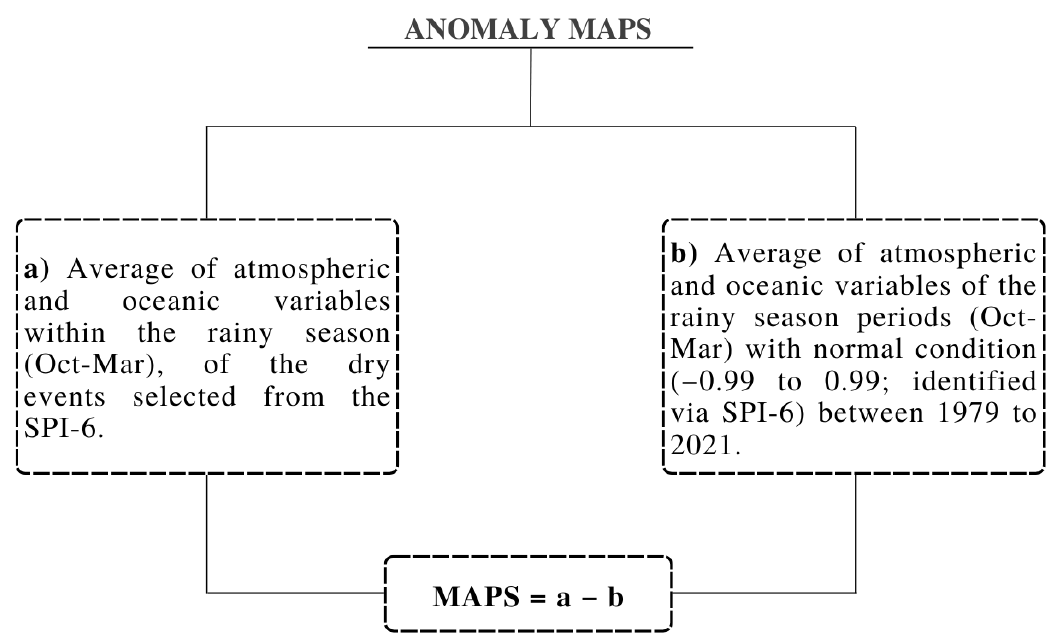
Figure 2. Flowchart summarizing the methodology applied in the present